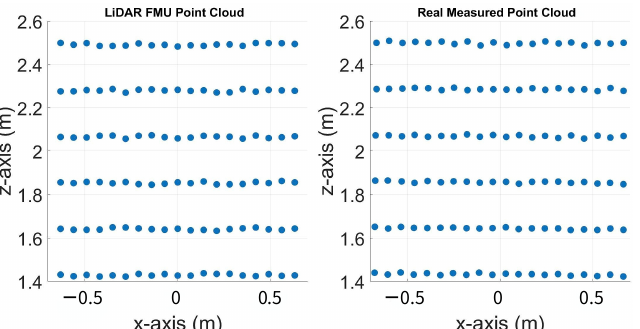
Figure 25. Visualization of LiDAR point clouds obtained from the real and simulated Lambertian plate placed at 20m. We removed the LiDAR points from the edges of the plate for the data analysis, as recommended in the standard. Therefore, the effective area of the plate becomes 1.3 ×